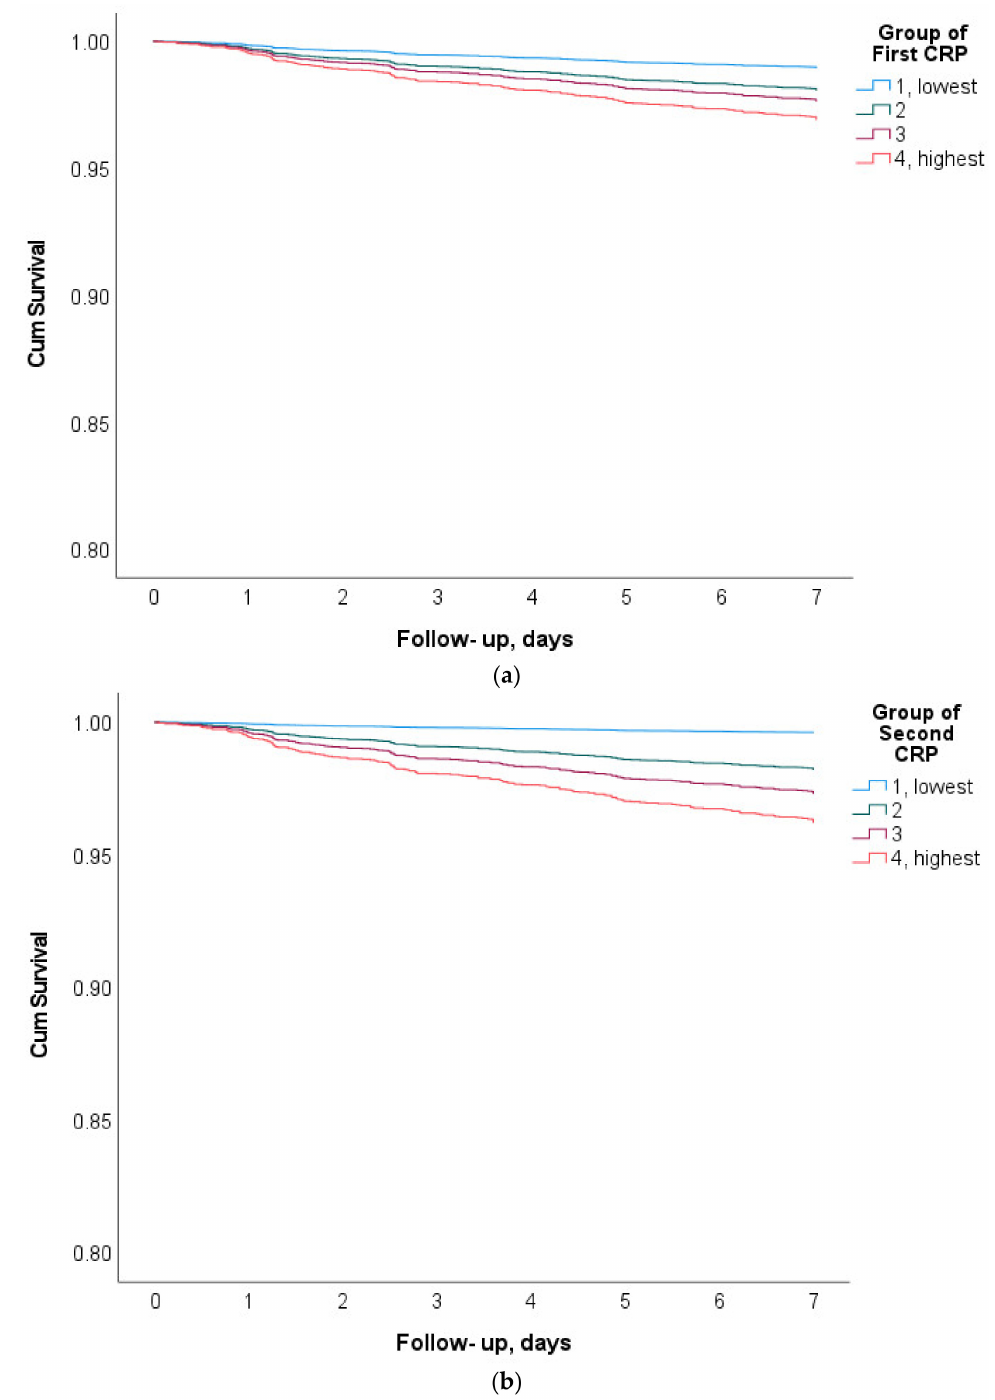
Figure 1. The survival plots for the first ( a ) and second ( b ) CRP quartiles (one is the lowest quartile, four is the highest). Log-rank mantel-Cox) < 0.001 for both. Of special interest is our finding that the sepsis cause of deaths increased in a dose dependent manner with the quartiles of the first and second CRP. Patients with an extreme low level of CRP (first quartile) not only had aa better survival rate, but also had a lower risk of mortality from sepsis compared to patients at the highest quartile of either the first or second measurement of CRP (6.7% and 0% of mortality from sepsis for patients at the first quartile compared to 54.4% and 47.0% at the fourth quartile of the first and second CRP measurements, Table